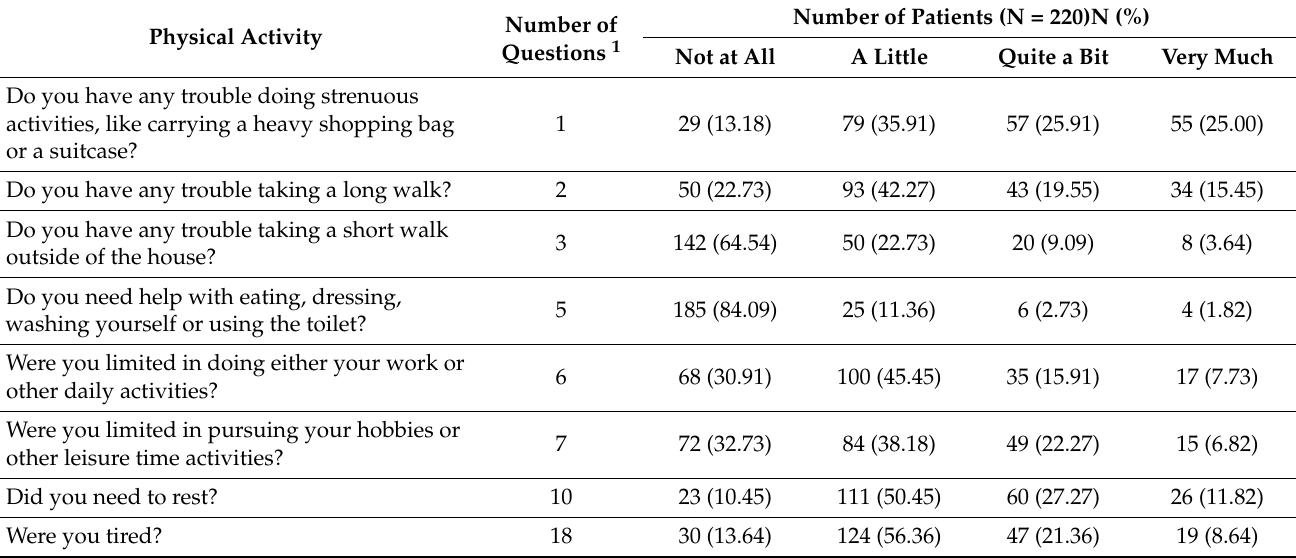
Table 2. Assessment of physical functioning made by the patients.